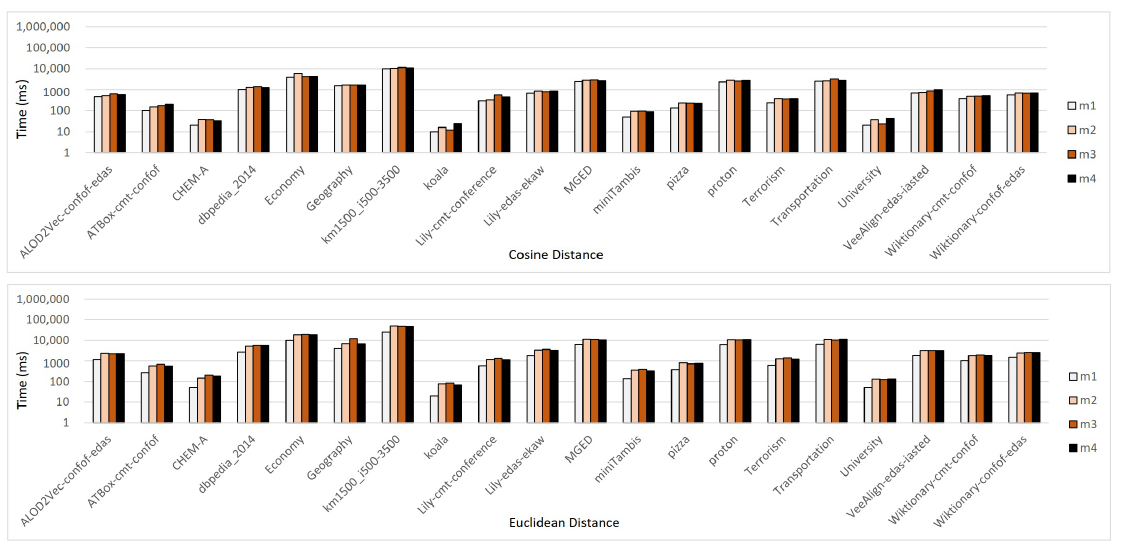
Figure 3. Time in milliseconds (y-axis) for each ontology to compute similarities for axiom pairs in each ontology by using two distance